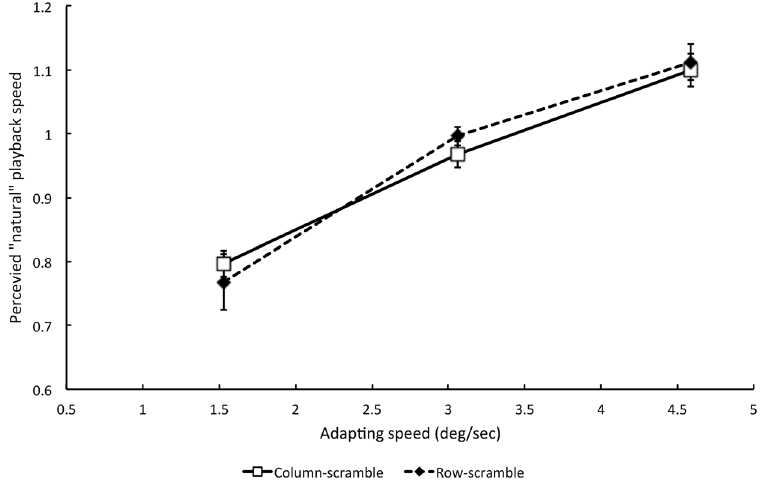
Figure 5. Results of Experiment 7 in comparison with Experiment 4, showing changes in apparently natural running speed after adaptation to scrambled running videos. Filled diamonds Data from Experiment 4 using row-scrambled adapt and test videos. Unfilled squares Data from Experiment 7 using column-scrambled adapt and test videos. Figure convention as in Figs 1 and 2. Each data point represents the mean P50 of five participants ( + / − 1 SE). An adapting speed of 3.06°/s corresponds to standard speed playback of